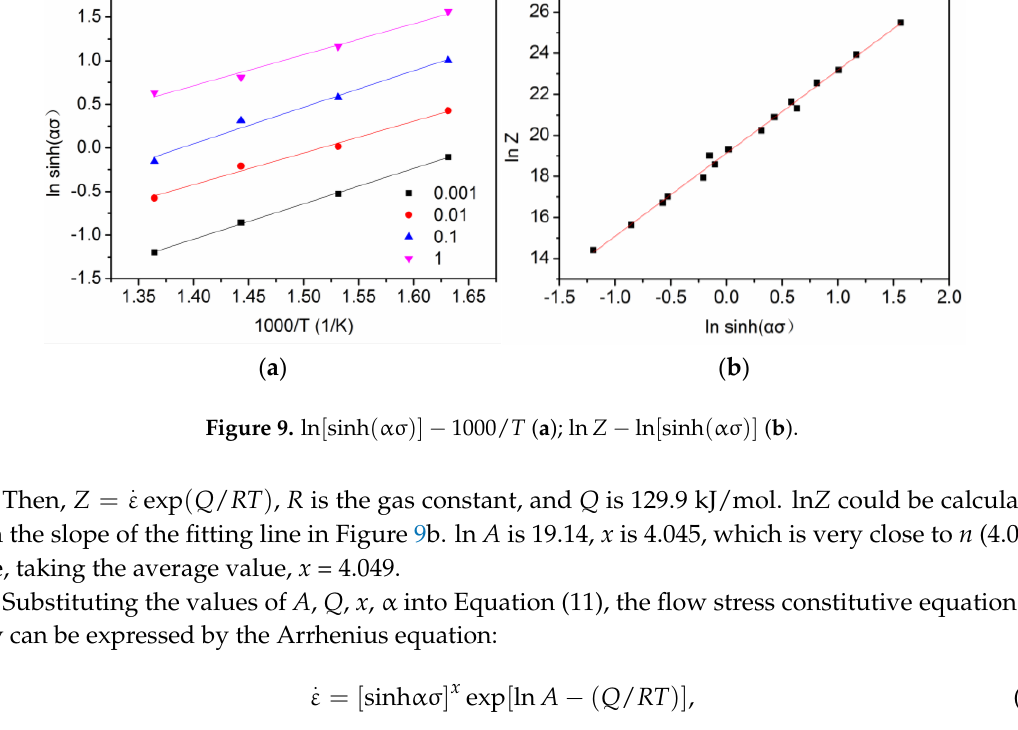
( c ) Figure 8. ( a ) lnε -σ; ( b ) lnε -lnσ; ( c ) lnε -ln[sinh(ασ)]. From Figure 8, it can be seen that the logarithm of the true stress and the logarithm of the strain rate met a linear relationship. In addition, flow stress, F (σ), could be described by Equation (8): (σ) [sinh(ασ)] x F